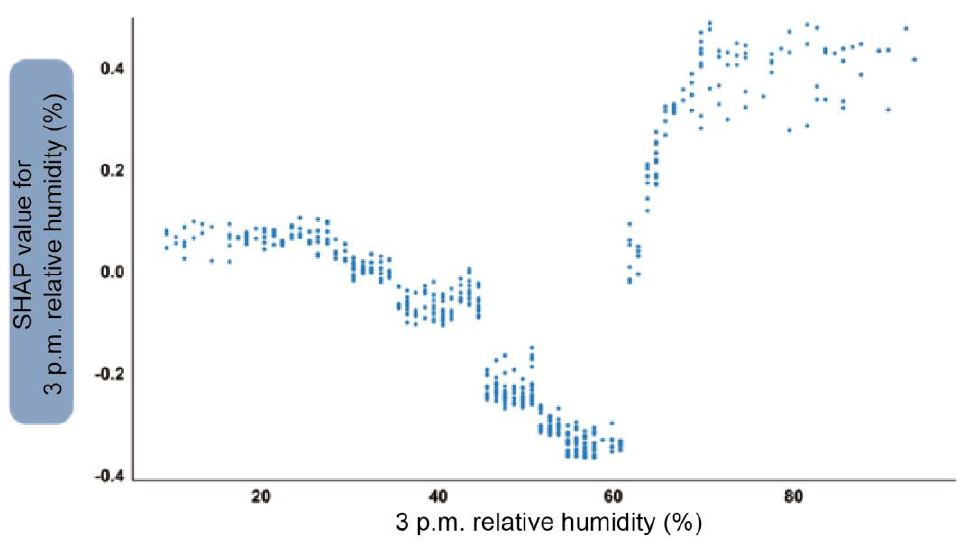
Figure 12. SHAP explanation of dependence plot for 3 p.m. relative humidity.